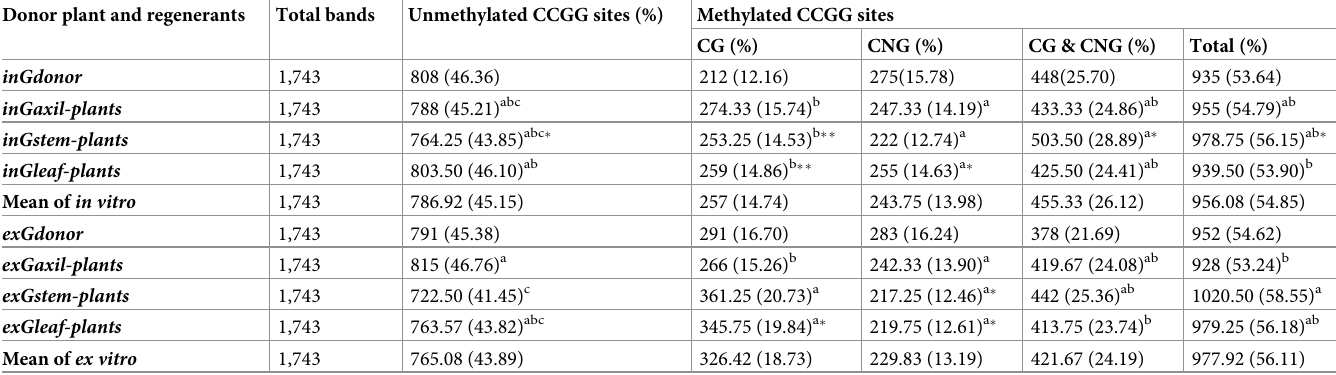
Table 3. Cytosine methylation level of L . ruthenicum G group based on MSAP analysis using 14 primer pairs. Donor plant and